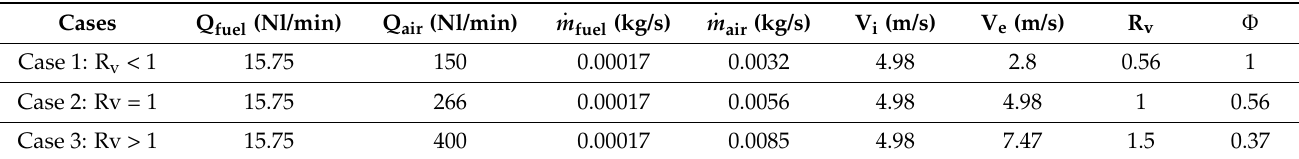
Table 1. Physical properties of the